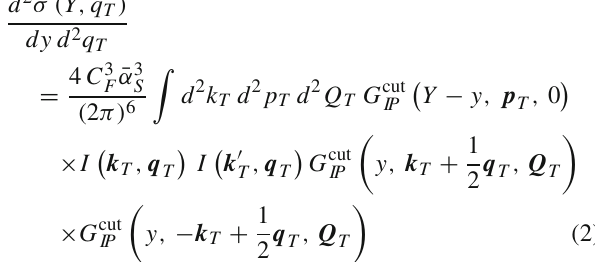
k+q/2 k’+q/2 −k+q/2 −k’+q/2 k − k’